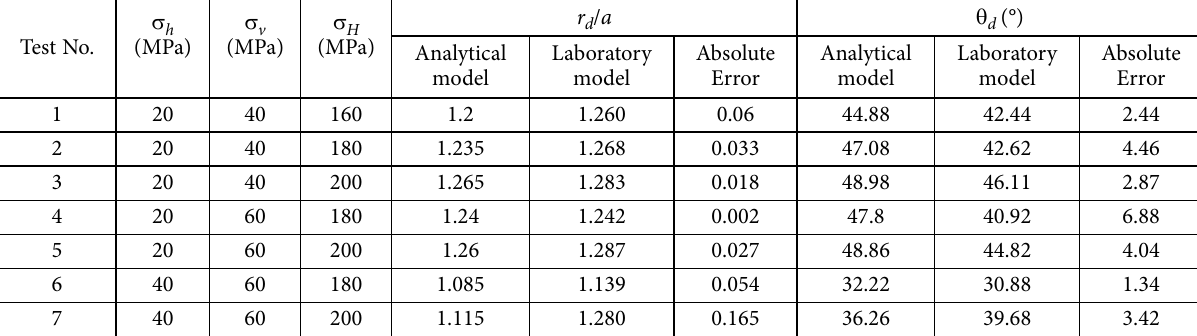
Table 2. Comparison between normalized failure depth ( r d / a ) and width obtained from analytical model and laboratory